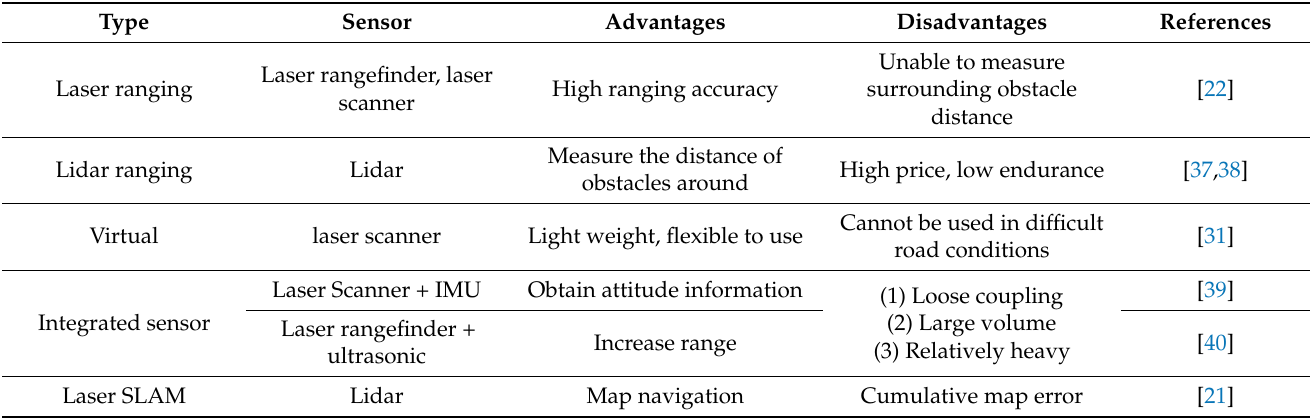
Table 1. A short summary of laser sensing smart